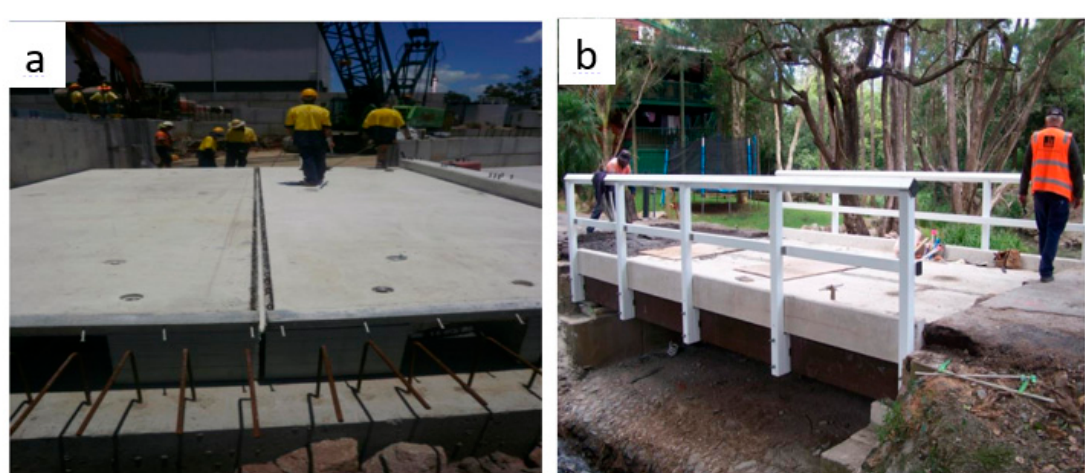
Figure 34. Application of GPC. ( a ) Prefabricated bridge, ( b ) deck bridge [192].